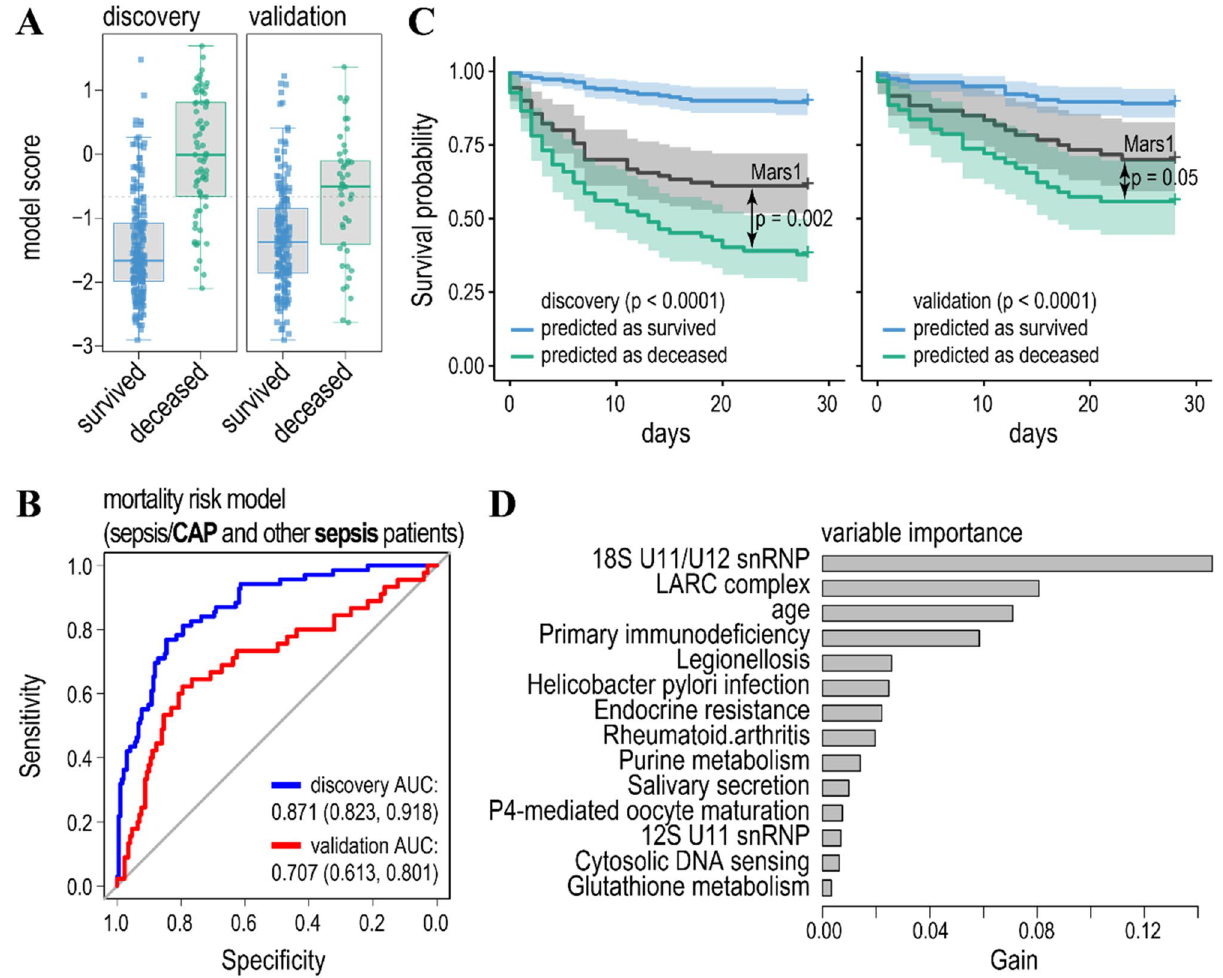
Figure 3. The model predicting mortality/survival of sepsis (grouped as sepsis/CAP and other sepsis) patients. ( A ) Boxplots of the model scores predicting mortality/survivorship in the discovery (left) and validation (right) cohorts. The model was trained on the same data as the published discovery cohort by the gradient boosted regression tree and validated on an independent cohort 8 . Dashed lines indicate threshold levels of classification. The threshold was calculated by maximizing a product of the specificity and sensitivity of the model prediction in the discovery cohort. Further details of model accuracy are given in Tables 2 and S2. ( B ) Receiver operating characteristic curves (ROC) for the model predicting mortality (endpoint—survival or death within 28 days after treatment) in sepsis (grouped as sepsis/CAP and other sepsis) patients (blue line—discovery cohort, red line—validation cohort). Features were selected by the t-test comparing gene ensemble noise between the survived and deceased patients in the discovery cohort to achieve maximum prediction accuracy for the discovery cohort. Values for the area under the ROC curve (AUC) are indicated. ( C ) Survival probability for the patients predicted to have low (blue line) and high (green line) risk of mortality for the discovery (left panel) and validation (right panel) cohorts. P -values indicate significant differences in hazards for the predicted classes (survival/mortality) according to the Cox proportional-hazards model. Black lines—survival probability of patients with Mars1 endotype 8 was compared with the predicted deceased class for the discovery and validation cohorts. ( D ) Variable importance of the model ranks gene ensemble noise features according to their relative contribution (deceased patients) increased (Table 2 and S2) in both the discovery and validation cohorts. Likewise, AUCs for the validation cohorts were also higher as compared to the model predicting mortality for both cohorts of sepsis patients (compare Fig. 4B and 5B with Fig. 3B). To that, differences in AUCs between discovery and validation cohorts were lower for the models predicting mortality separately for sepsis/CAP and sepsis patients as for the model trained on both types of patients. This was especially evident for the model predicting mortality for the sepsis/CAP patients (Fig. 4B). Thus, knowing the cause of sepsis improves the prediction accuracy of the models. Finally, it has to be noted that both the feature selection and gradient boosted regression trees allow for the ranking of the model features’ importance (Figs. 3D, 4D, 5D, and Table S3). First, it turned out that a patients’ age does not noticeably contribute to the prediction of mortality in sepsis/CAP patients and it ranks low in the prediction of mortality of sepsis patients. Second, high ranking gene ensembles (pathways) could immediately